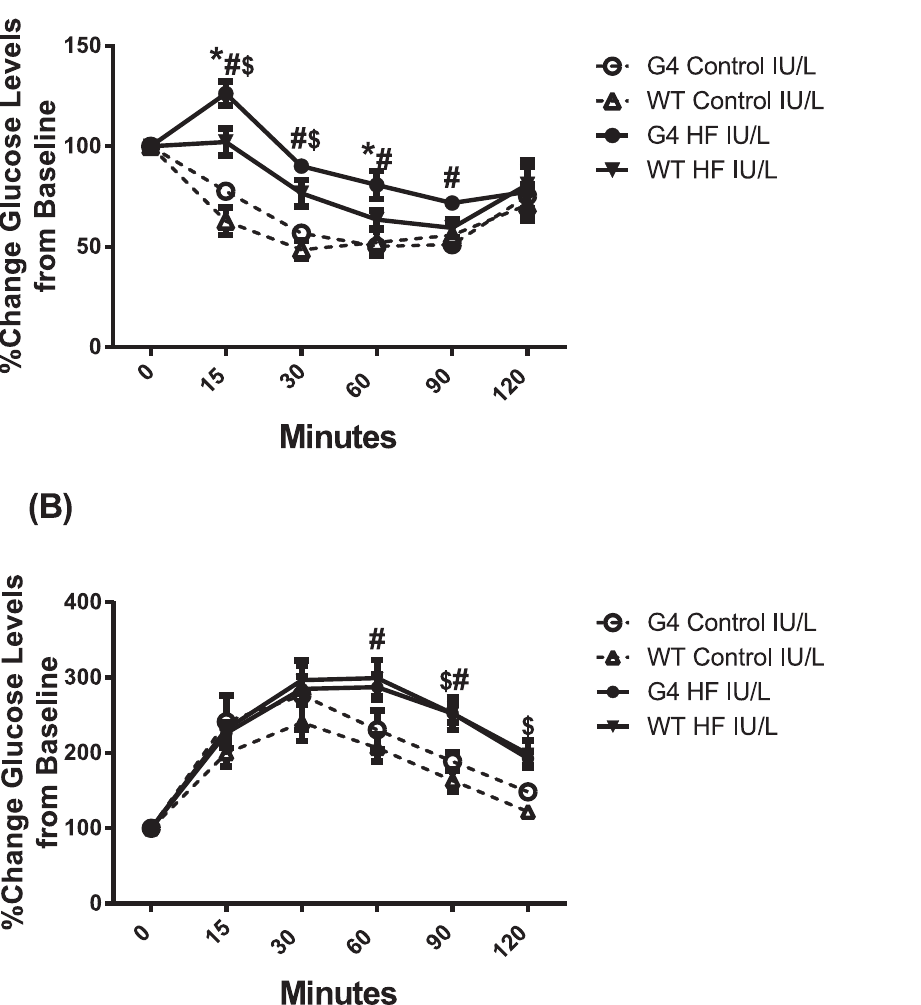
Figure 3. Impaired insulin and glucose tolerance IPGTT in WT and G4 + / 2 mice exposed to HF IU/L. (A) ITT, following a 6 hr fast blood glucose levels were assessed at the indicated times following an i.p. injection of 0.75 U/kg insulin. Values are represented as the percent of t=0 glucose levels, *p , 0.05 G4 + / 2 HF IU/L vs. WT HF IU/L; # p , 0.02 G4 + / 2 HF IU/L vs. G4 C IU/L; $ p , 0.05 WT HF IU/L vs. WT C IU/L. (B) GTT was performed following an overnight fast, mice were i.p. injected with 1.5 g/kg glucose and blood glucose levels determined at the indicated times, n=5 per group. Values are represented as the percent of t=0 glucose levels, # p , 0.05 G4 + / 2 HF IU/L vs. G4 + / 2 C IU/L; $ p , 0.05 WT HF IU/L vs. WT C IU/L.